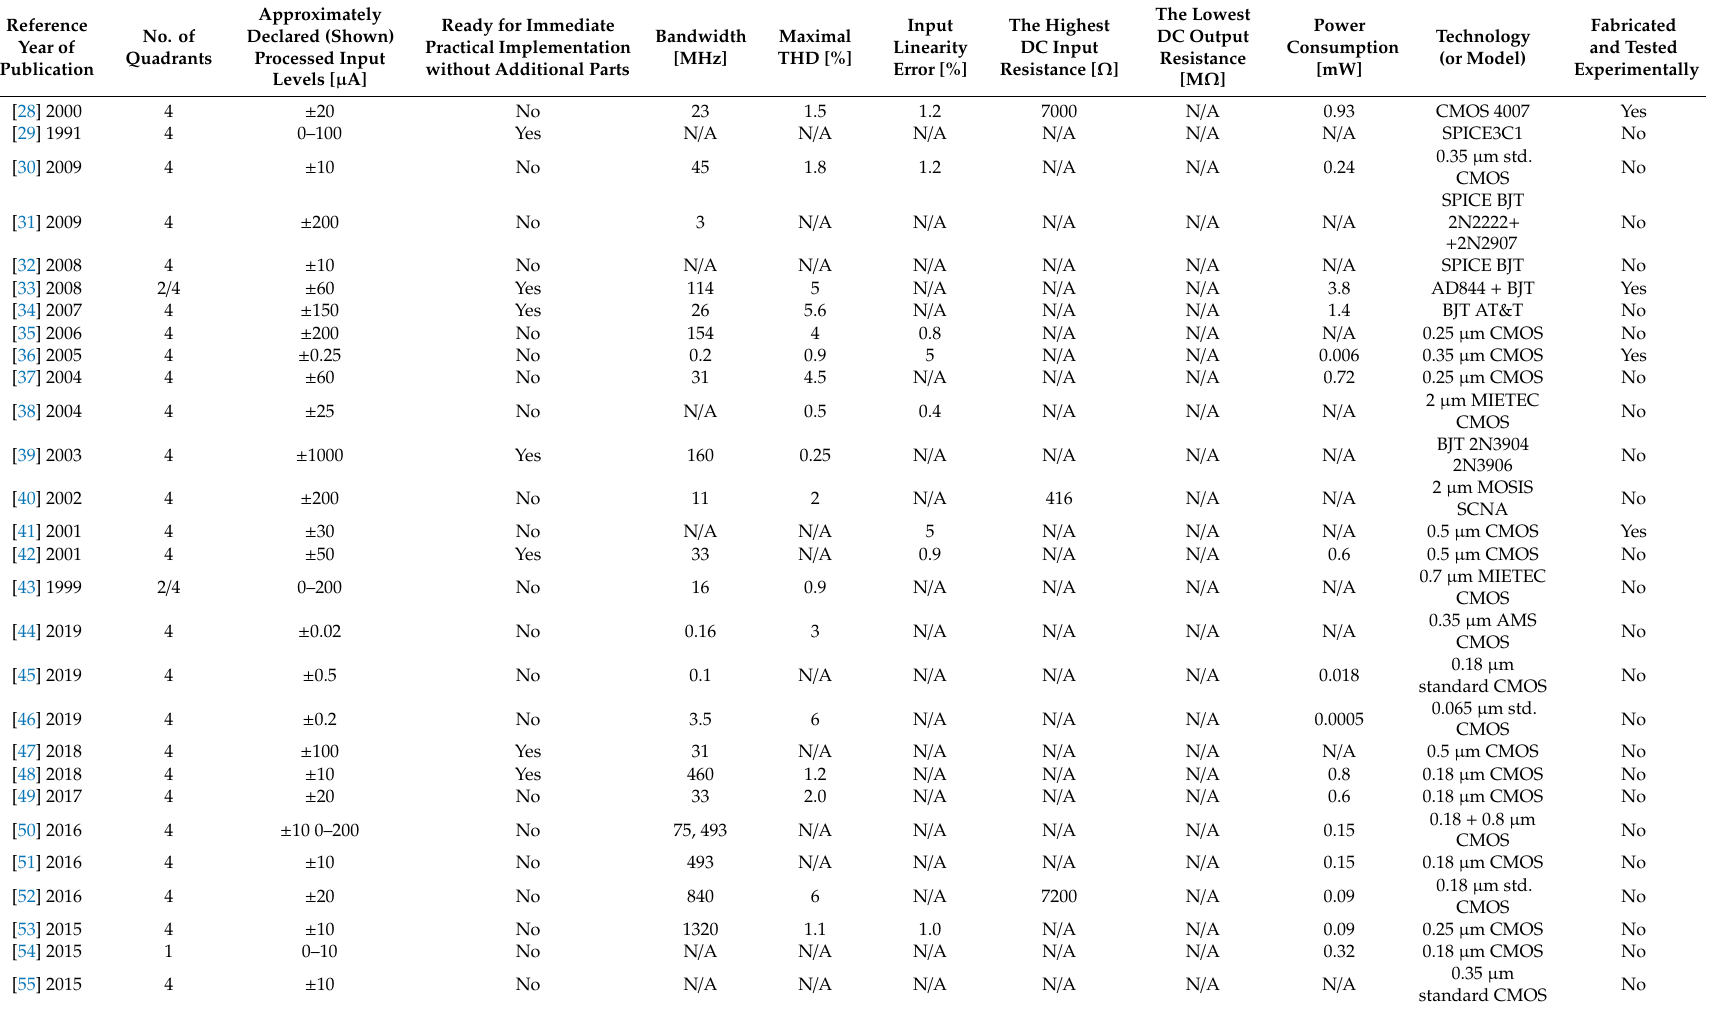
Table 2. Comparison of recent current-mode